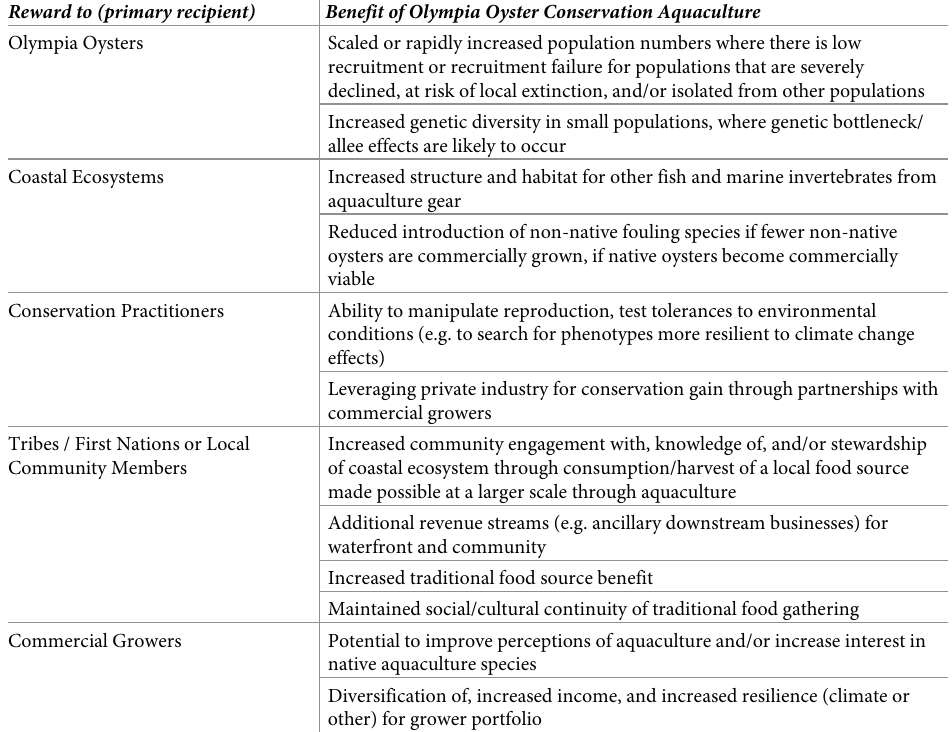
Table 2. Potential rewards of conservation aquaculture of Olympia oysters, organized by primary recipient group. Only those rewards uniquely associated with conservation aquaculture, not with oyster restoration through any means (e.g. water filtration), are